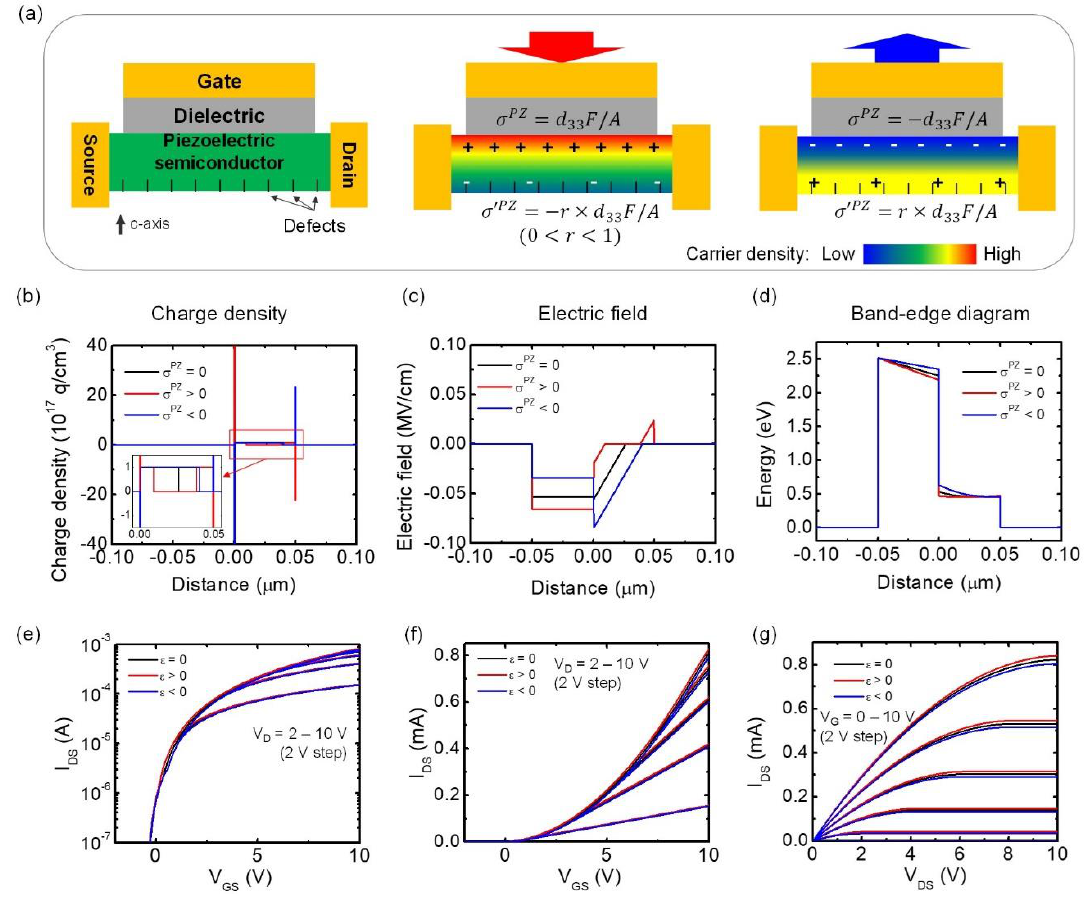
Figure 2. Piezoelectric MIS thin-film transistors (TFTs). ( a ) Schematic diagram of the device with compressive and tensile out-of-plane stress. ( b – d ) Plots of the ( b ) charge density (Inset: detailed charge density distributions inside the film region), ( c ) electric field, and ( d ) energy band edge across the gate, under compressive and tensile stress, respectively. ( e – g ) Transfer and output characteristics of the MIS TFTs with and without stress generated from the analytic solutions. ( e ) Transfer curves plotted in semilog scale and ( f ) the same curves plotted in linear scale. ( g ) Output curves. Black, red, and blue curves represent no stress, compressive stress, and tensile stress, respectively.